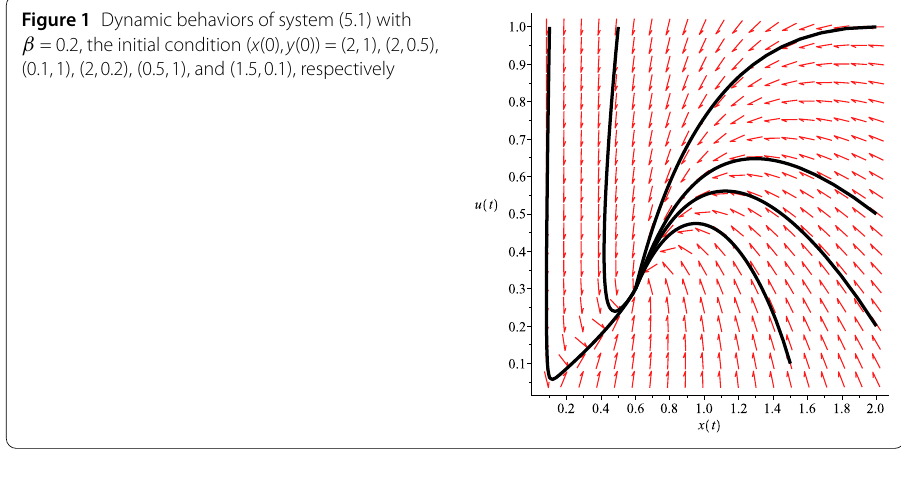
Figure 2 Dynamic behaviors of the first component of system (5.1) with the initial condition ( x (0), y (0)) =